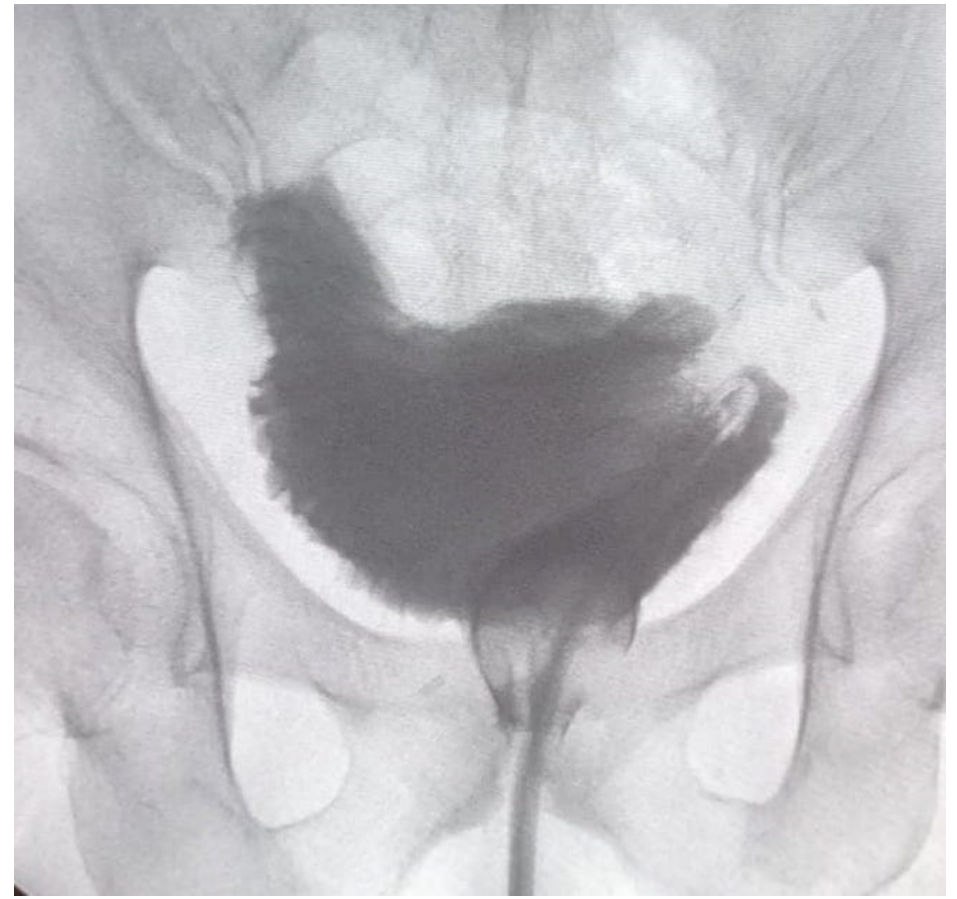
Figure 1. Orthotopic neobladder at a cystogram performed 18 days after surgery, before removing the urethral catheter.